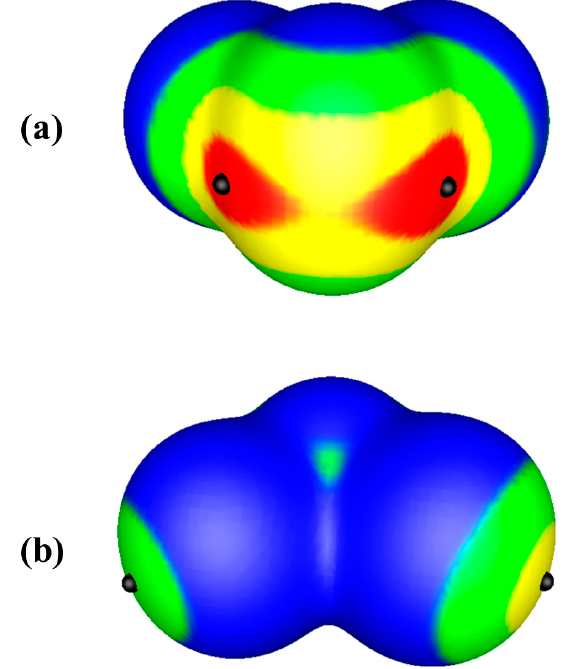
Figure 1. Computed electrostatic potentials on the 0.001 au molecular surface of SeClBr. In ( a ), the selenium is in the foreground, the chlorine is in the rear left, and the bromine in the rear right. In ( b ), the chlorine is in the foreground left and the bromine in the foreground right. Color ranges, in kcal / mol: red, more positive than 24; yellow, between 24 and 12; green, between 12 and 0; blue, negative. Black hemispheres indicate the most positive potentials (V S,max ) corresponding to the two σ -holes on the selenium, on the extensions of the Cl–Se and Br–Se bonds, and the σ -holes on the chlorine and bromine, on the extensions of the Se–Cl and Se–Br bonds.